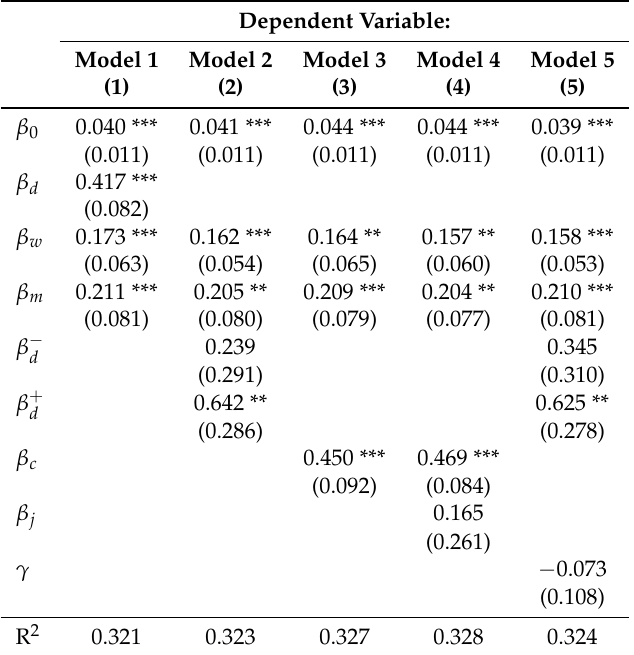
Table 2. HAR-RV estimation results—1-day